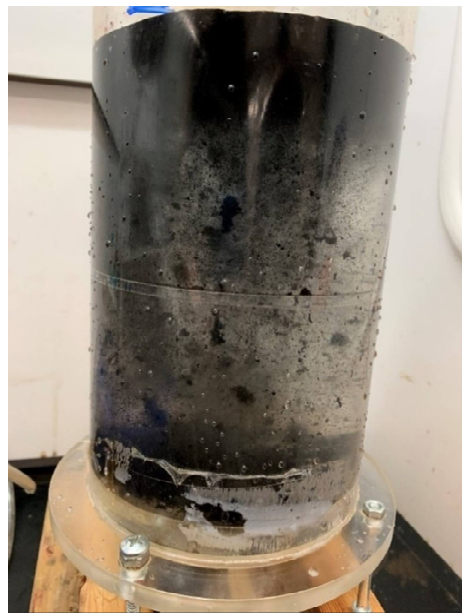
Figure A1. The visualization of biochar pellet dissolution during agitation demonstrated using DI water.